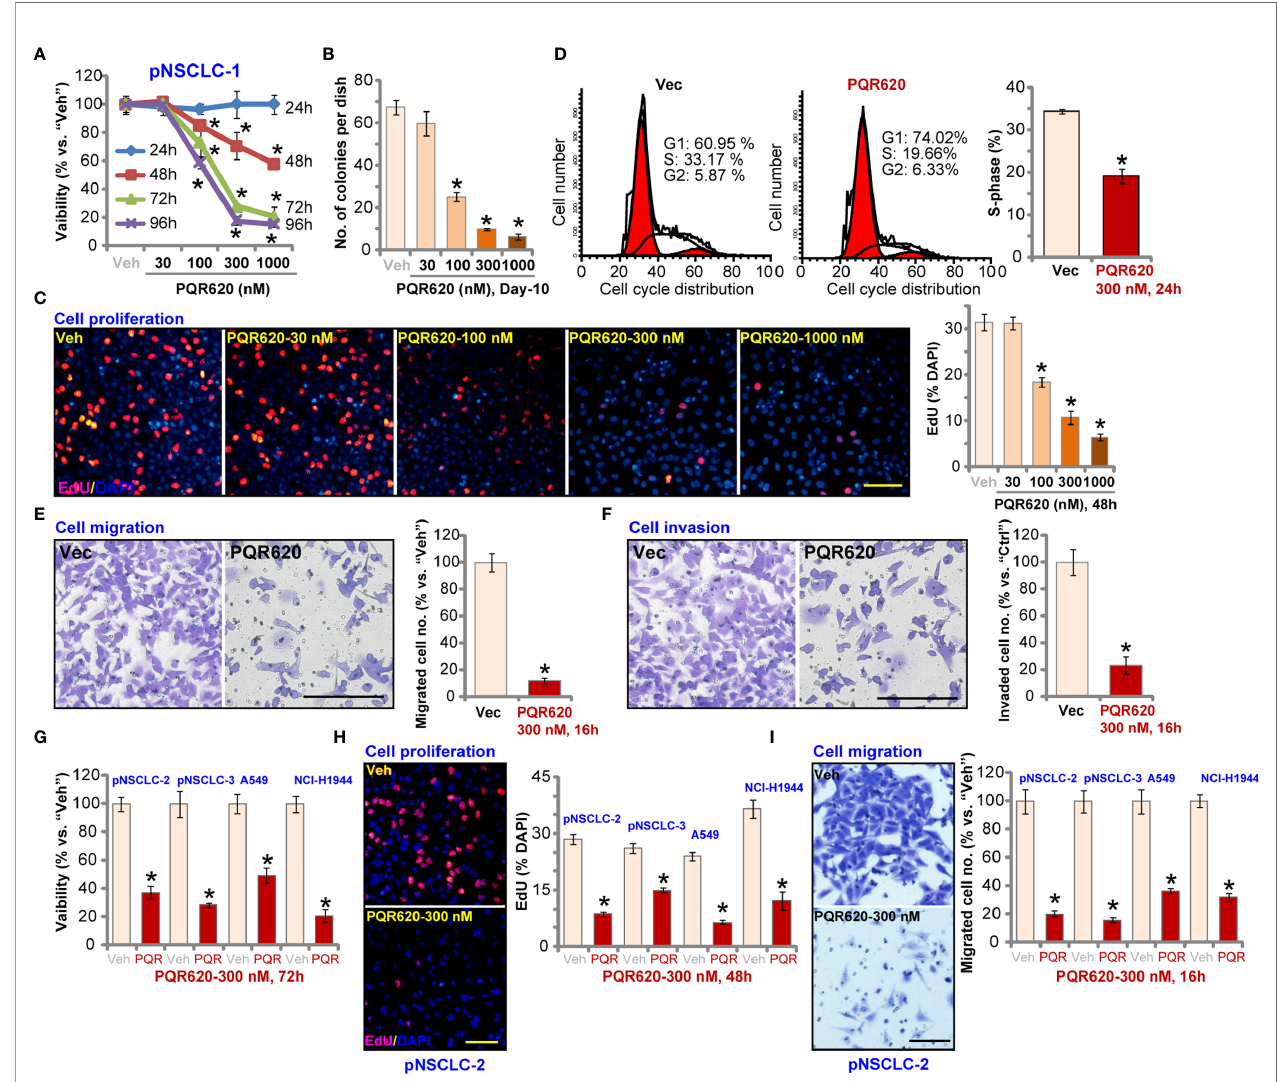
FIGURE 1 | PQR620 exerts robust anti-NSCLC cell activity. Primary NSCLC cells that were derived from three different patients (pNSCLC-1/-2/-3) and established cell lines (A549 and NCI-H1944) were treated with PQR620 (at applied concentrations) or vehicle control ( “ Veh ” ). Cell viability (CCK-8 OD, A , G ), colony formation (results were quanti fi ed, B ), cell proliferation (EdU incorporation, C , H ), cell cycle progression (PI-FACS, D ), cell migration (E, I) and invasion (F) were tested by the described assays. Data were presented as mean ± standard deviation (SD, n=5). * p < 0.05 vs. “ Veh ” cells. Experiments were repeated fi ve times with similar results. Scale bar= 100 m m (C, E, F, H, I)